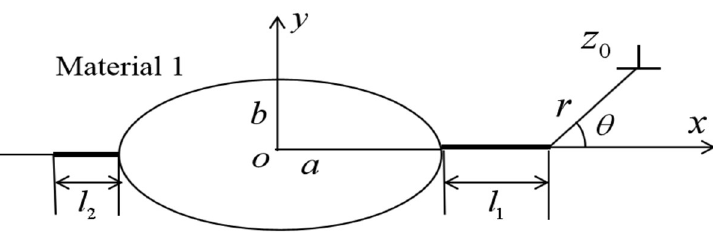
Figure 1. A screw dislocation interaction with two unequal interface cracks emanating from an elliptical hole in a QC piezoelectric bi-material.